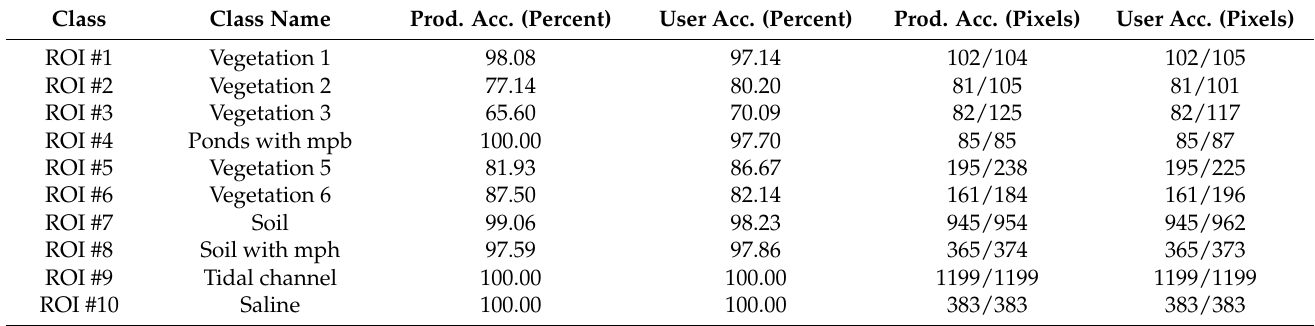
Table A7. Report for the accuracy of the comparison of classification results to Sp20, the stratified- proportionate samples group using 20% of total pixels as reference. The table summarizes the producer accuracy and user accuracy in percentage and pixels for each